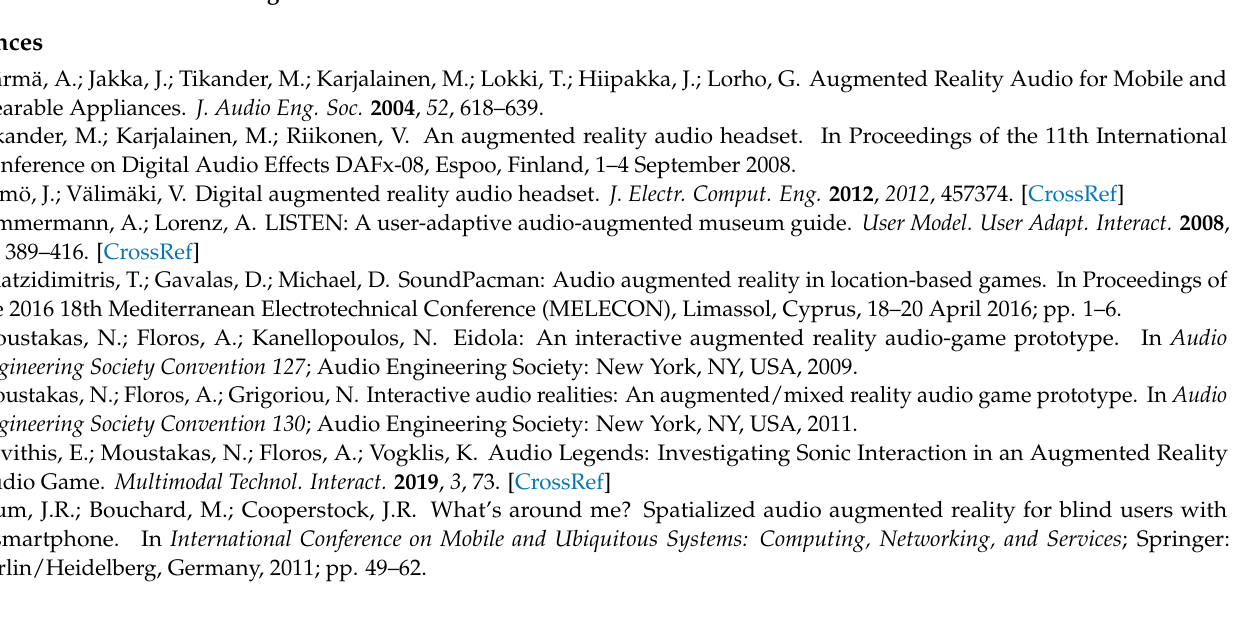
Figure A4. MUSHRA test